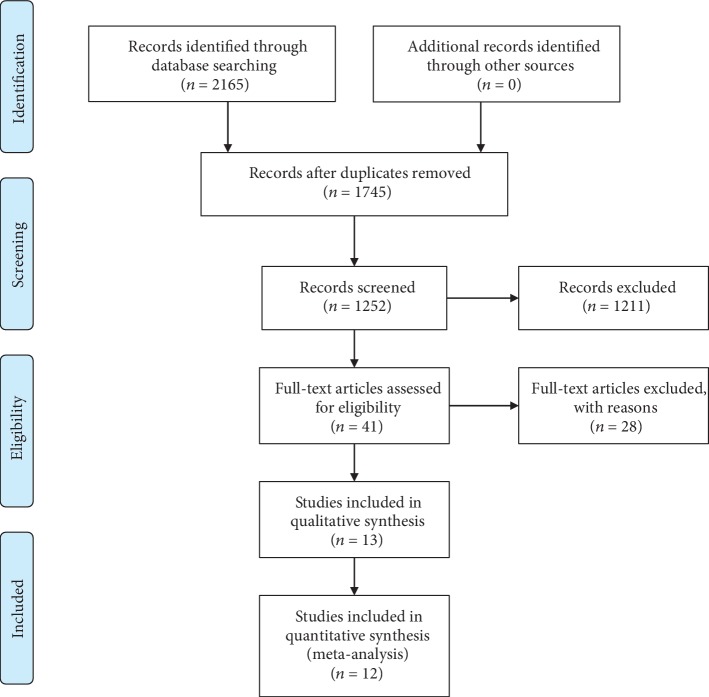
PRISMA flowchart presenting the steps of record search and selection.